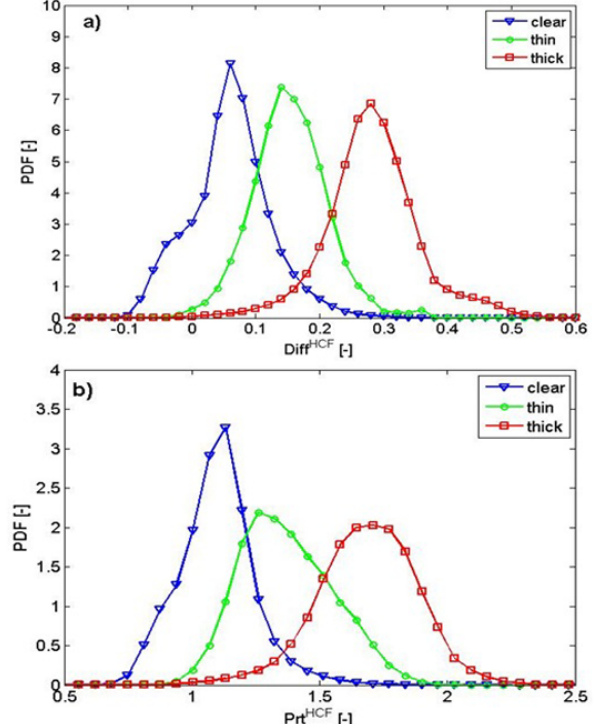
Fig. 7. PDF of the training set for each class with HCF applied for (a) Diff HCF (Eq. 6); (b) Prt HCF (Eq. 8).